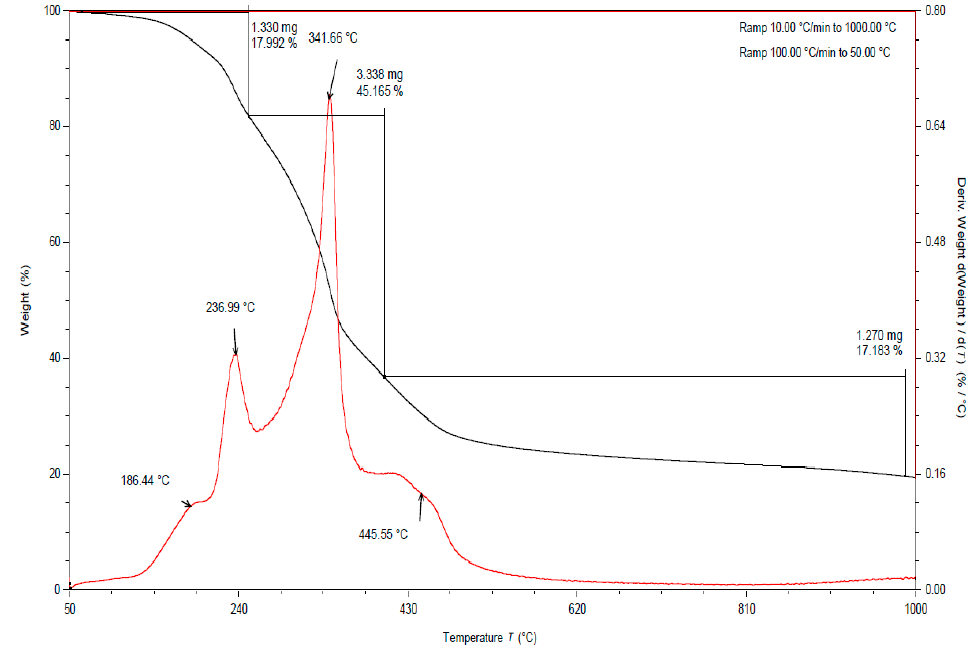
Figure 1. TGA curve for apple pomace dried at 60 °C. Analysis under nitrogen atmosphere (black line is a curve of mass loss versus temperature, red line is the first derivative).